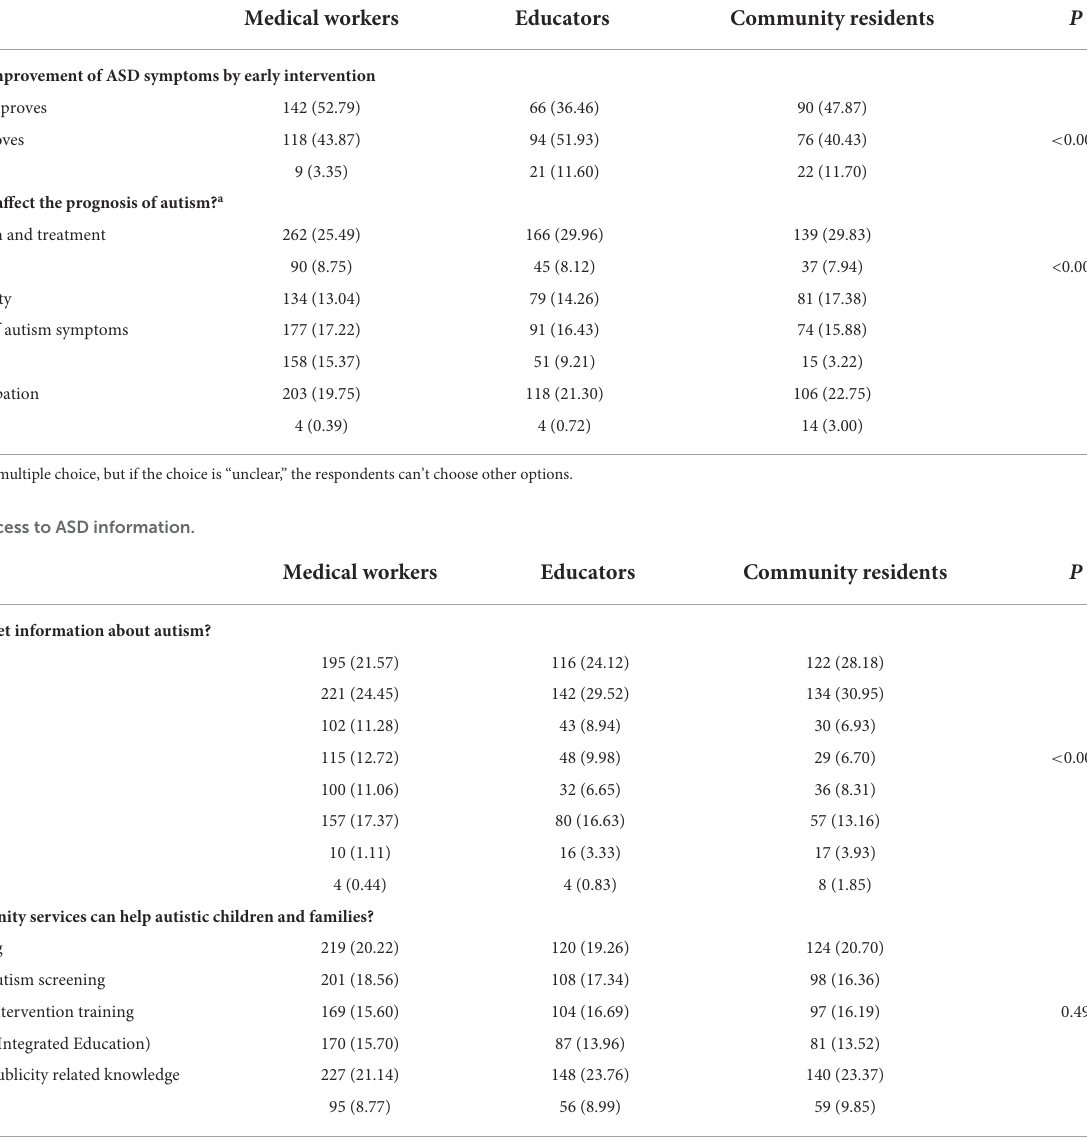
TABLE 5 Awareness of the prognosis of ASD and influencing factors. Medical workers Educators